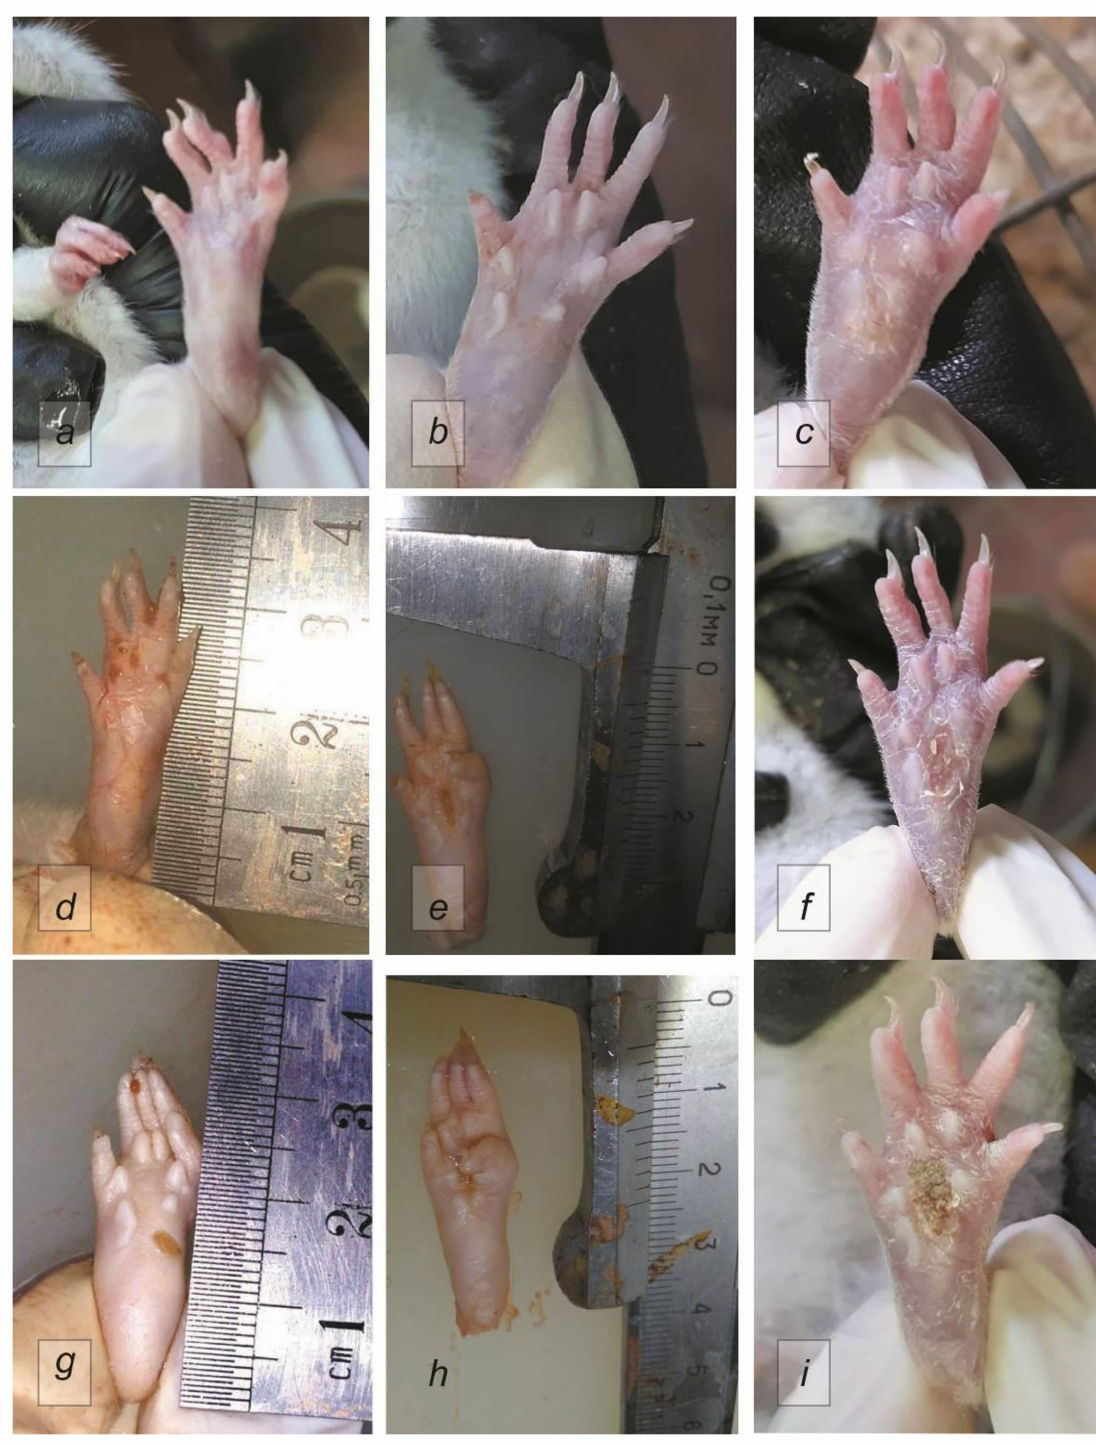
Figure 1. Left hind paws of rats. ( a ) Sham; ( b , c ) control after 7 and 21 days, respectively; ( d – f ) 7, 14, and 21 days after treatment with Cytos-11, respectively; ( g – i ) 7, 14, and 21 days after treatment with Humira,